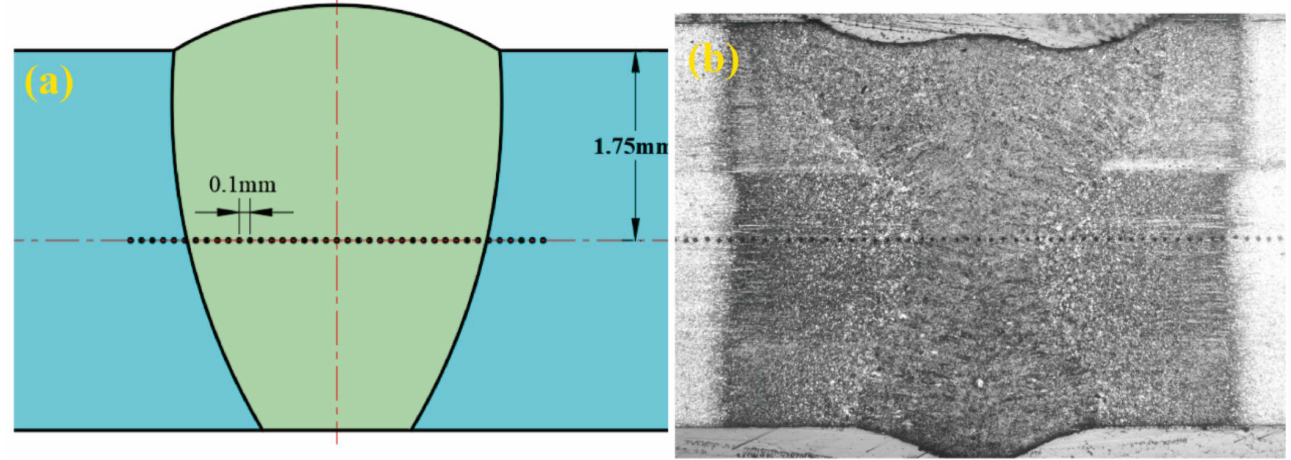
Figure 4. Distribution of microhardness test points: ( a ) schematic illustration; ( b ) test illustration.